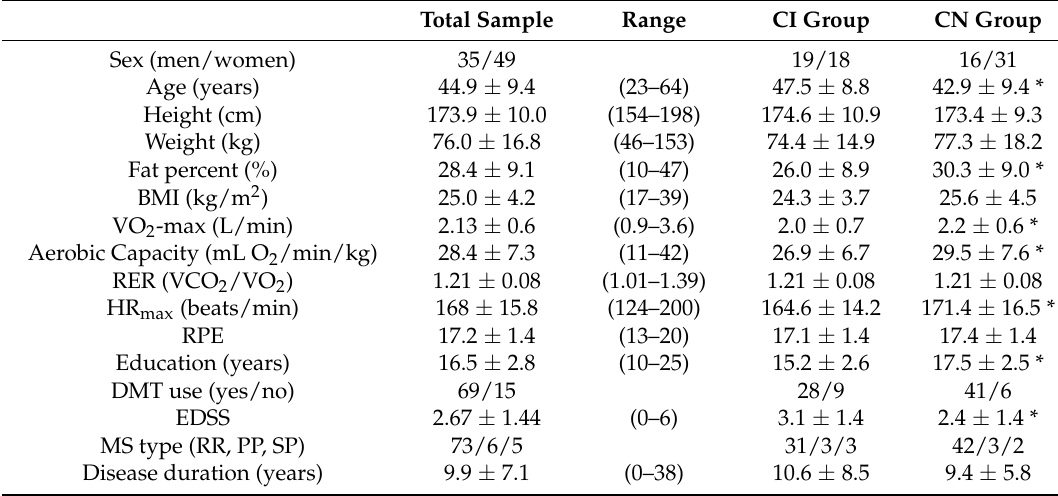
Table 2. Subject